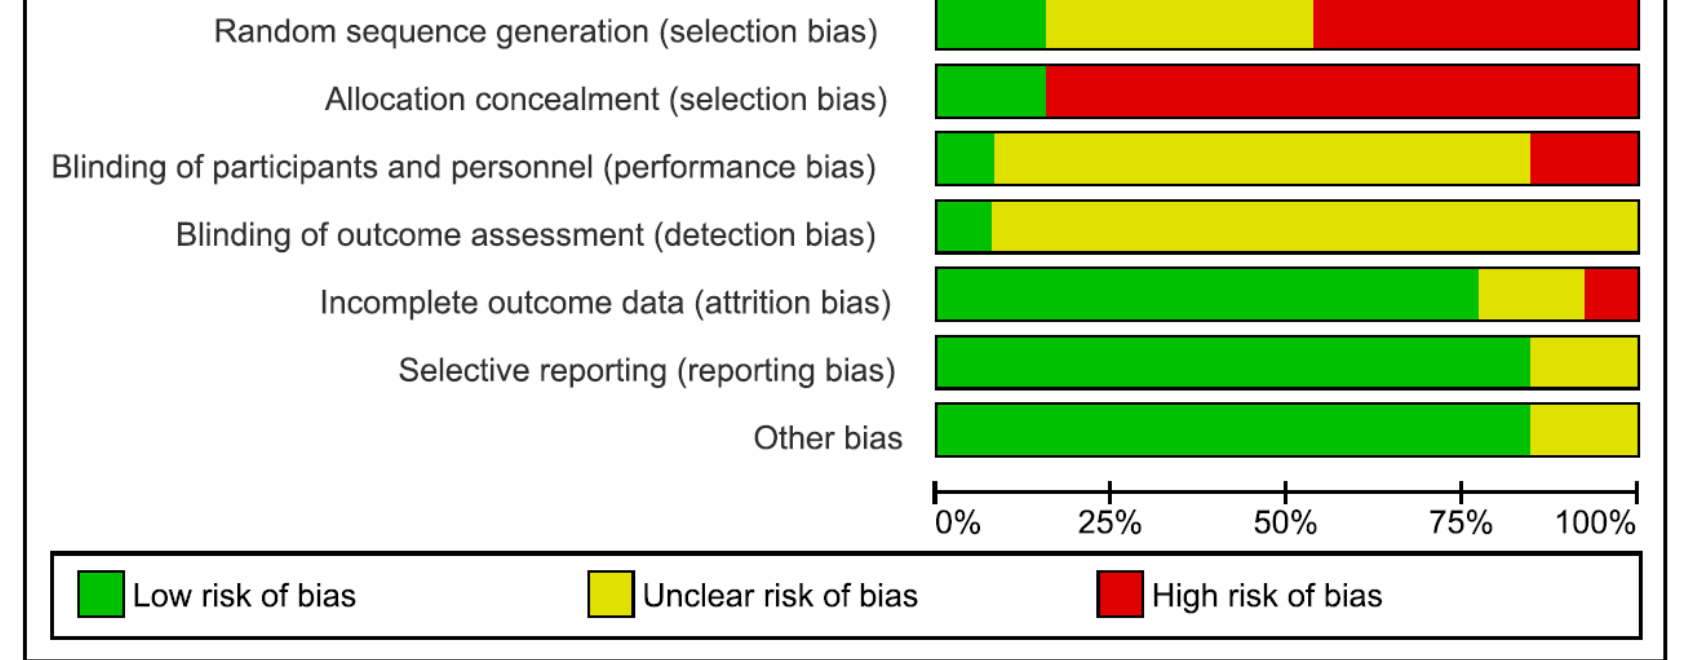
Figure 3. Risk of bias graph: review authors' judgements about each risk of bias item presented as percentages across all included studies.